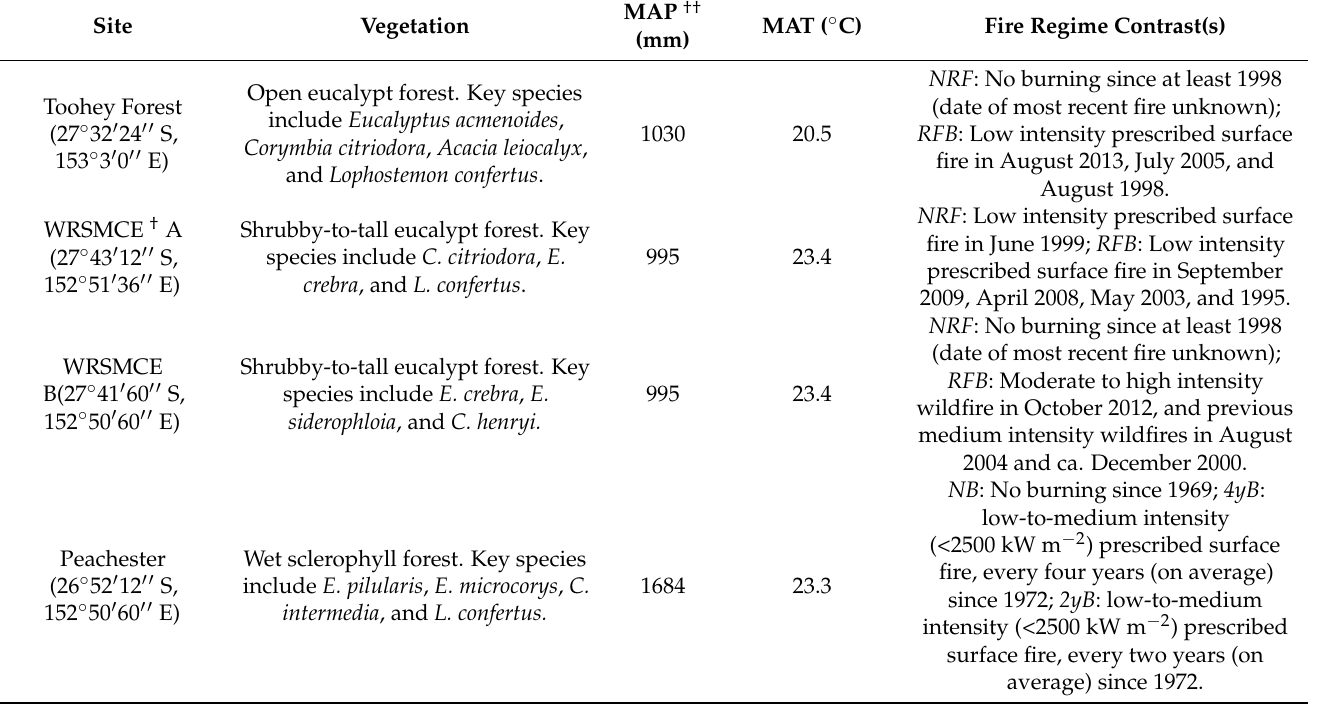
Table 1. Location, vegetation community, climatic, and fire regime details for study sites.